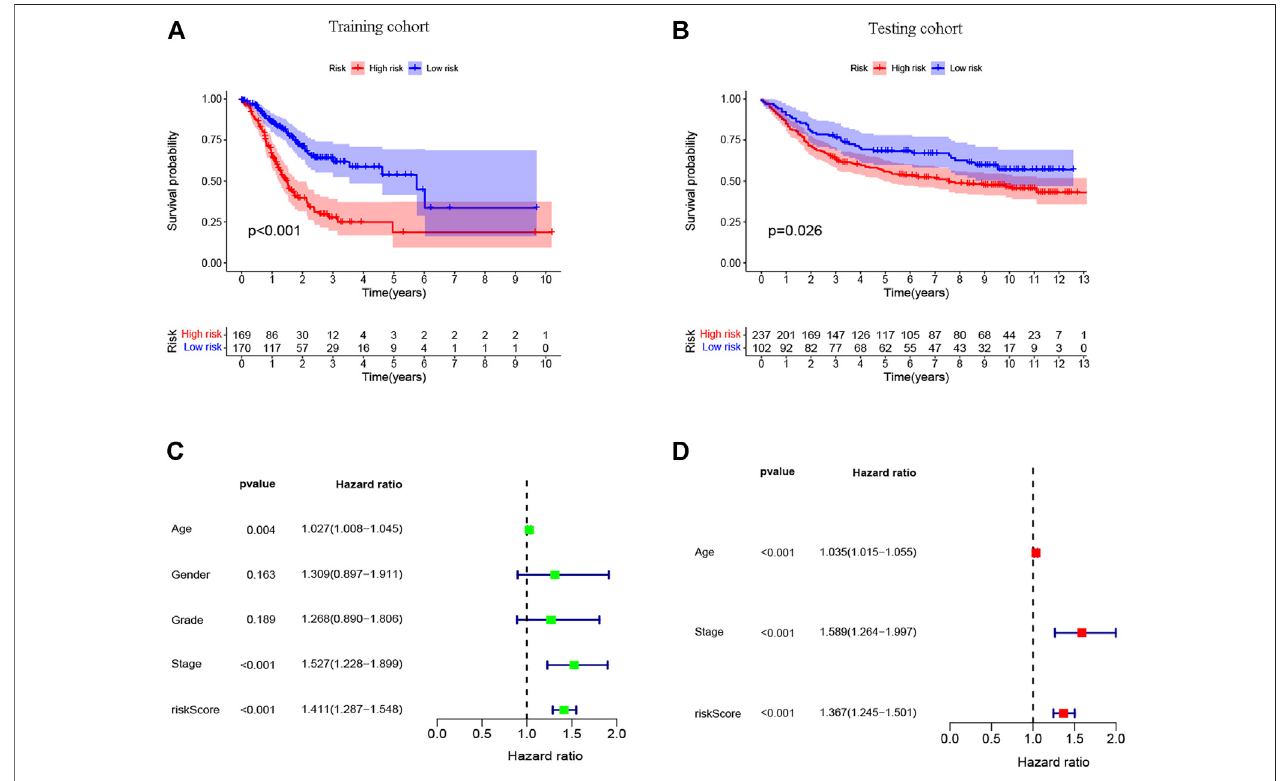
FIGURE 5 | Survival analysis of the prognostic immune signature in the (A) training (TCGA) and (B) testing (GEO) cohorts, and independent prognostic analysis of the immune signature. (C) The univariate and (D) multivariate Cox regression analysis of clinical parameters and risk score.